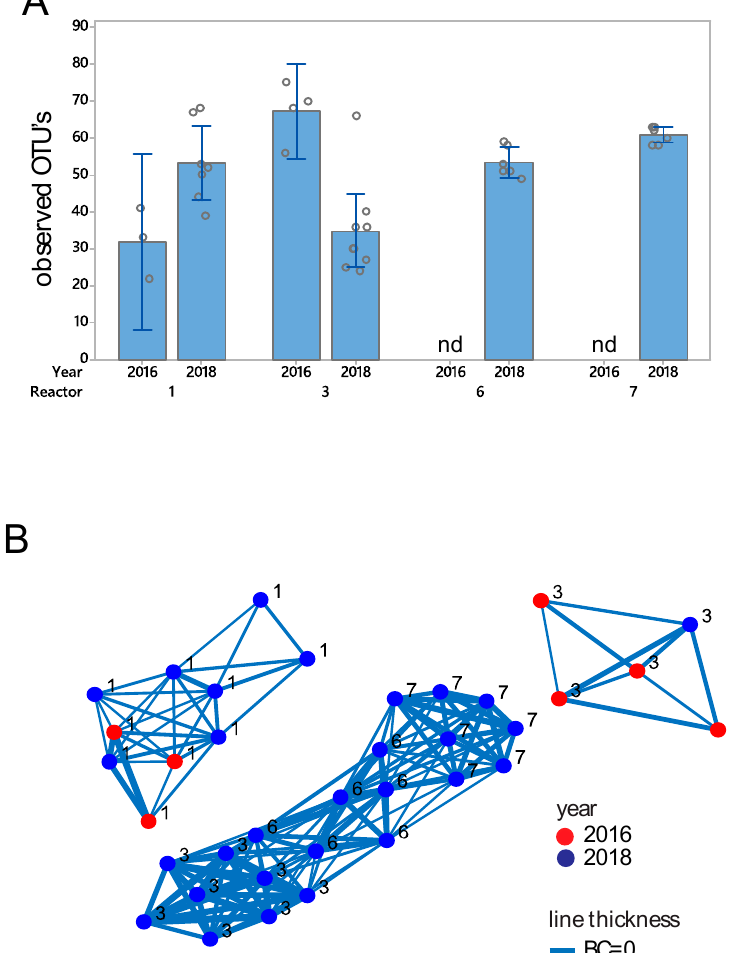
Figure 3. Eukaryote diversity measures. ( A ) α -diversity, as represented by observed species. Error bars represent standard deviations. ( B ) β -diversity, as represented by Bray–Curtis (BC) distances. Each sphere represents a biofilm. Bray–Curtis distances are represented with lines, with an inverse relation between distance and line thickness, with distances < 0.5 being connected. The analyses were performed on the 36 samples with number of sequences above the rarefaction threshold of 10,000 sequences for the 18S rRNA